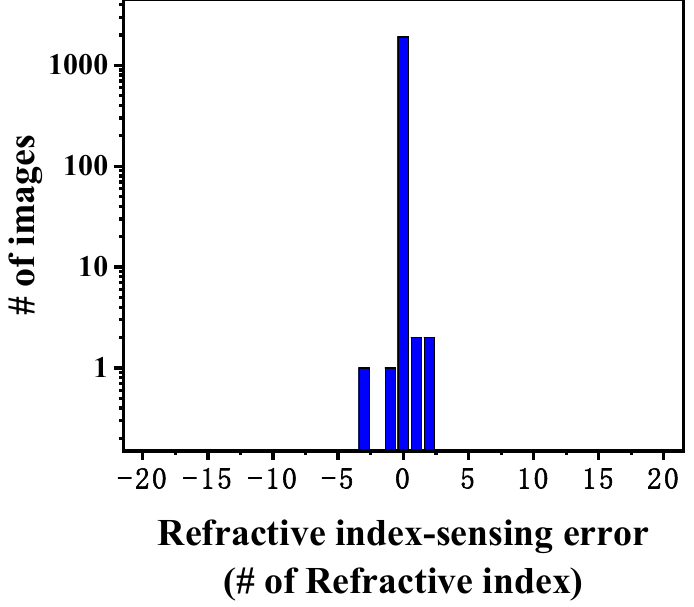
Figure 6. The histogram of the absolute refractive index classification error.